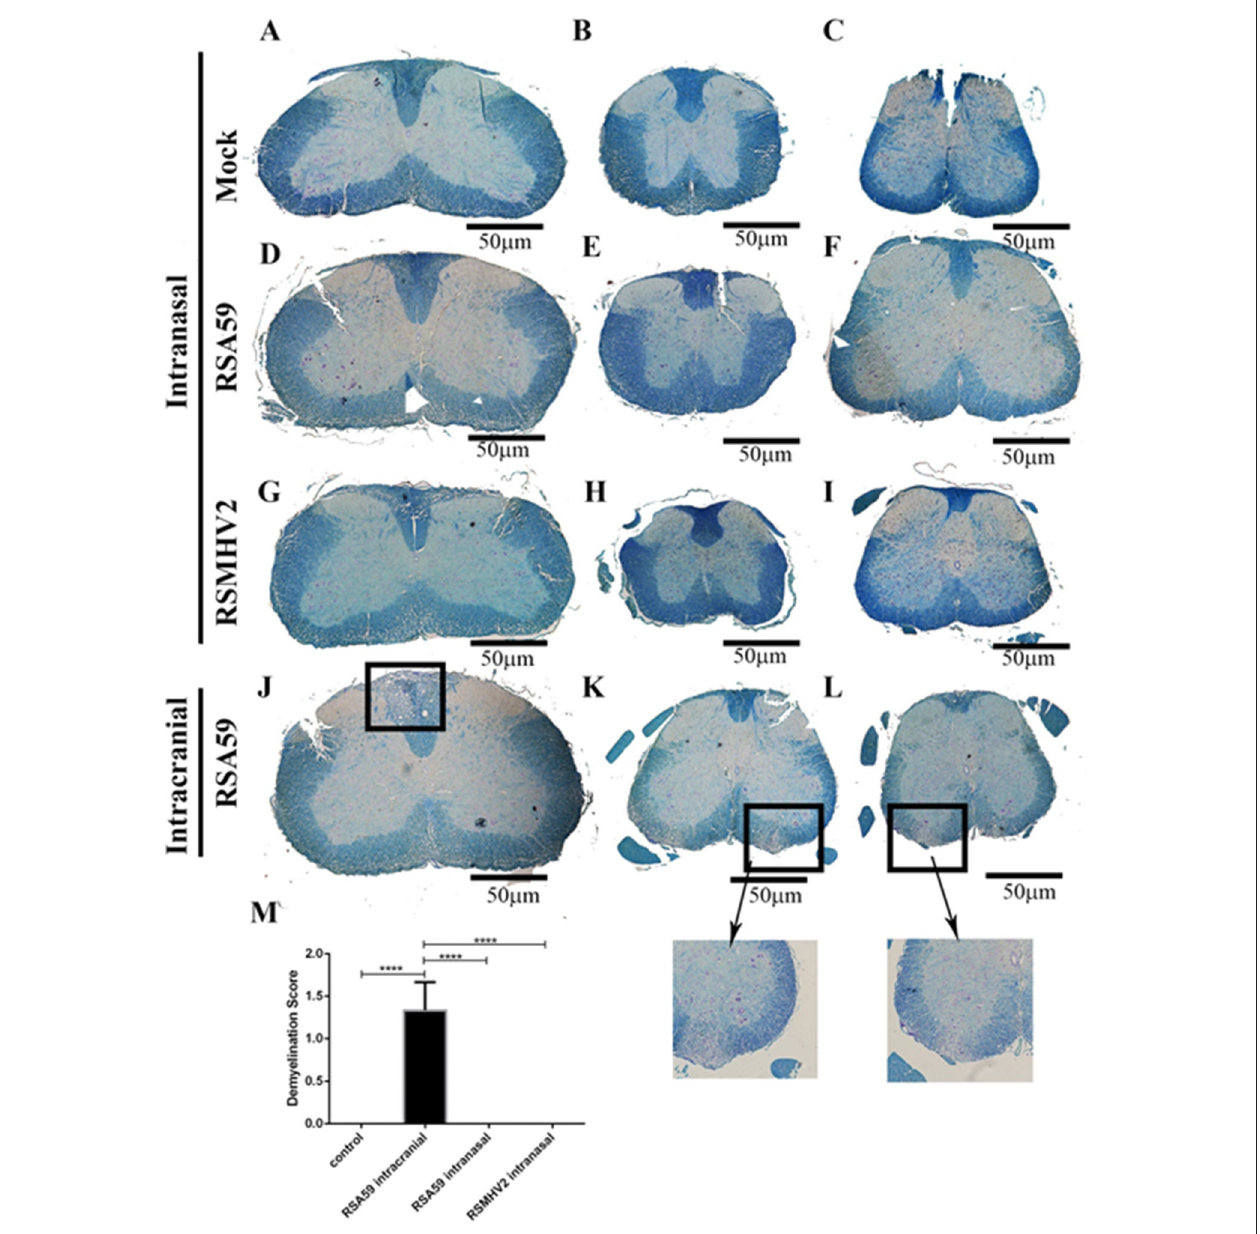
FIGURE 1 | Comparative demyelination study between intracranially inoculated and intranasally infected mouse spinal cords. Serial thoracic (left column), cervical and lumbar (center and right columns) cross sections of spinal cord from post-inoculation day 26 intranasally mock-infected (A–C) , RSA59-infected (D–F) , and RSMHV2-infected (G–I) mice, and intracranially RSA59-inoculated mice (J–L) were stained with LFB (scale bar = 50 µ m). Marked area indicate typical demyelinating plaques found in spinal cord white matter. Average demyelination score is 1.33 ± 0.2357; (mean ± SE) (M) ; n = 9/group; data comparisons were done by one-way ANOVA and Tukey’s Multiple Comparison post-hoc testing with GraphPad Prism 6.0 software. **** p <